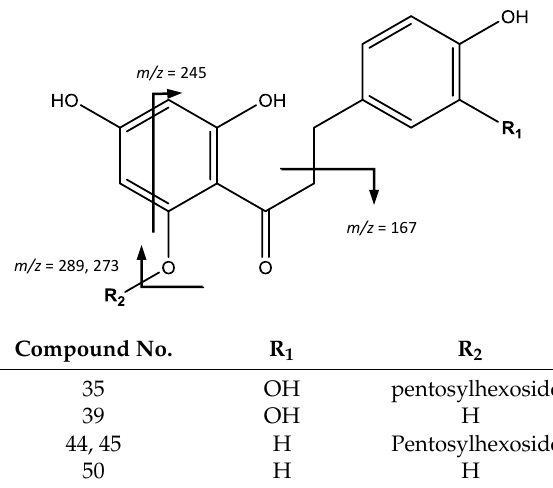
Figure 9. Chalcones structure and main fragments.